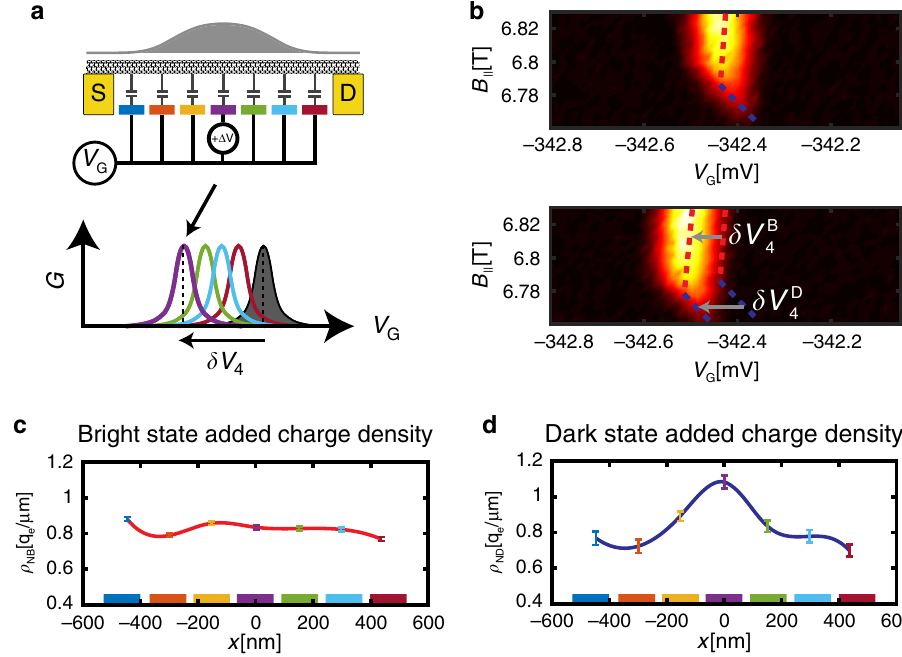
Fig. 3 Imaging the bright and dark states ’ spatial charge distributions. a The charge distribution of a state is imaged by measuring its independent capacitances to each of the individual gates (colored). This is achived by monitoring how the state ’ s Coulomb blockade charging peak (gray, bottom) shifts in common gate voltage, V G , when a small voltage perturbation, Δ V , is added to each of the gates (colored peaks). The individual shifts are directly proportional to the local charge densities above the corresponding gates. b Top: Zoom-in on the triple point in the white box in Fig. 2c. Bottom: Same triple point when a perturbation Δ V = 0.5 mV was added to gate 4. Bright and dark states charging lines (dashed red and blue) have independent shifts along V G , labeled δ V B and δ V D . c Measured spatial distribution of the bright state added charge, ρ NB ( x ), where x is the spatial coordinate along the nanotube. Colored 4 4 points (with 1 σ con fi dence errorbars) correspond to the voltage shifts measured with the corresponding gates (colored gates are plotted along the x axis at their actual spatial cordinates). The red spline connecting the measured points is a guide to the eye. Notably, the bright state charge is spread rather homogenously along the suspended nanotube. d Similarly measured spatial distribution of the dark state added charge, ρ ND ( x ), observed to be concentrated at the center of the con fi nement